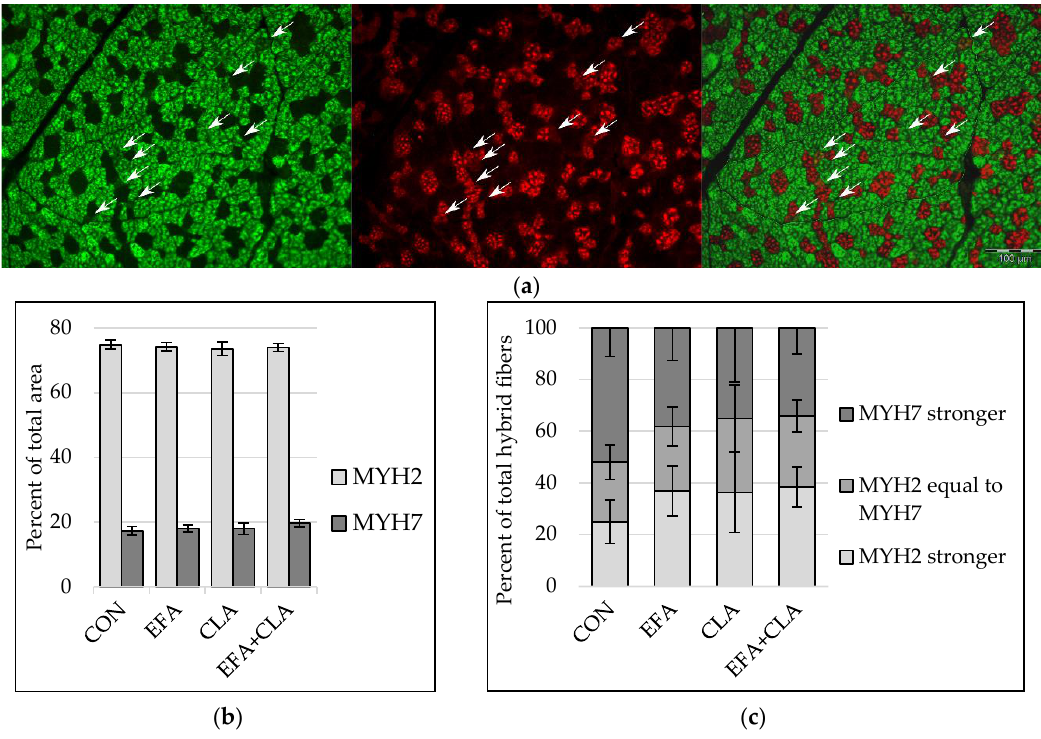
Figure 2. Immunohistochemical detection of myosin heavy chain isoform 2 (MYH2) and isoform 7 (MYH7) in longissimus muscle of calves of four maternal supplementation groups: Control group (CON, n = 8), essential fatty acids (EFA, n = 9), conjugated linoleic acids (CLA, n = 8), EFA + CLA (n = 11). ( a ) Representative immunofluorescence images of muscle fiber cross-sections stained for MYH2 (left, green), MYH7 (middle, red) and merged (right). Arrows indicate hybrid fibers. Scale bar = 100 µm. ( b ) Area percentage of MYH2 and MYH7 expressing fibers. ( c ) Percentage of total hybrid fibers for hybrid fiber groups, formed according to signal intensity. Data are shown as LSM ± SE LSM . The protein abundances of myosin heavy chain isoforms 1, 2, 7, and 8 were quantified by western blots. For representative blot pictures of target protein and total protein, see Supplemental Figure S2. There were no differences among the supplementation groups observed ( p > 0.05, Figure 3) for any of the investigated MYH isoforms.